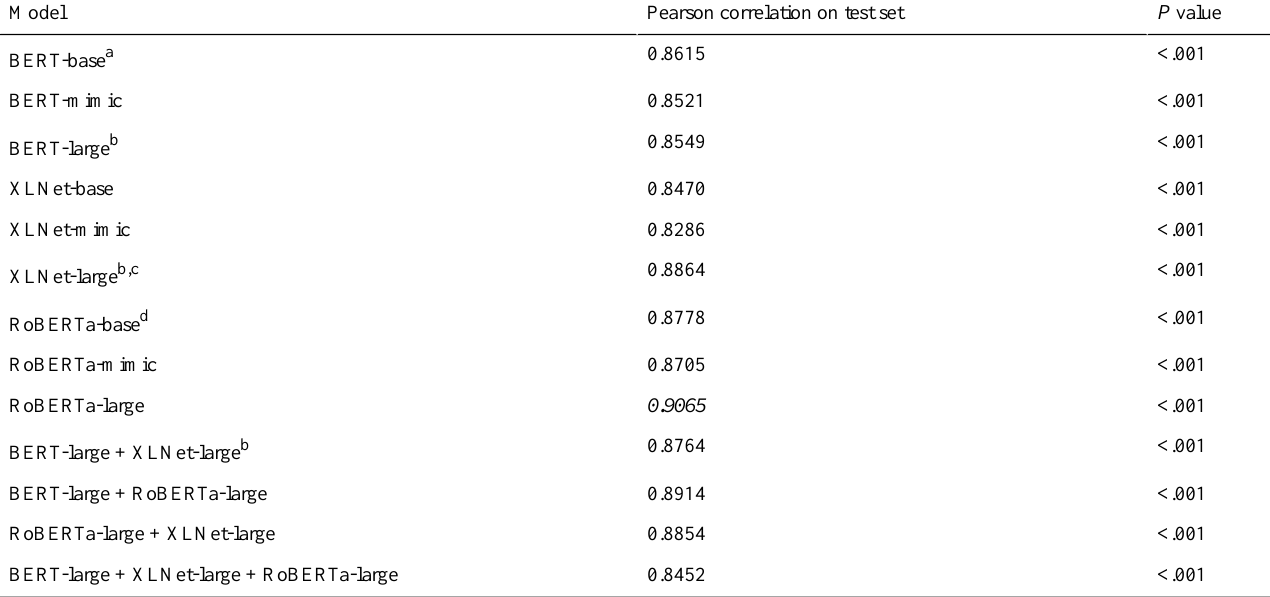
Table 3. Performances of the Pearson correlation on the test set.